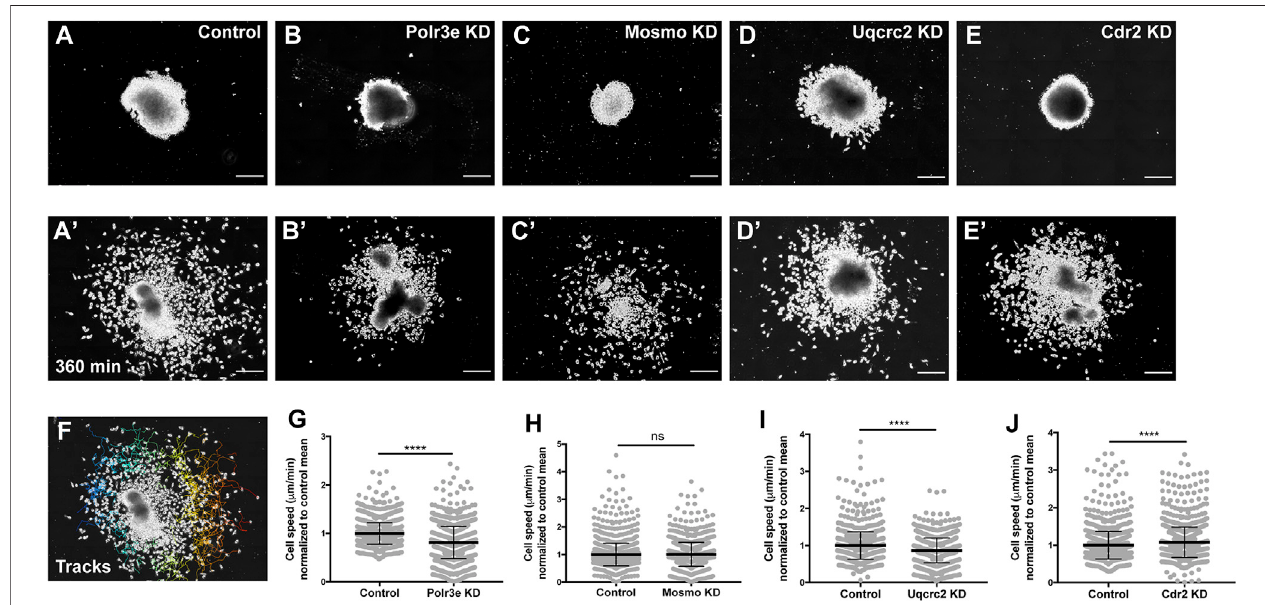
FIGURE 4 | Manipulation of Polr3e, Uqcrc2, and Cdr2 impacts NCC migration speeds in vitro . Dissected NCC explants from control, Polr3e KD, Mosmo KD, Uqcrc2KD,orCdr2KDembryoswereplatedon fi bronectin-coatedcoverslips,allowedtoadhereandbeginmigration,andimagedfor6 husing20xphasemicroscopy. (A – E) Representative images of explants at initial timepoint (0 min). (A 9 – E 9 ) Representative images of explants after 6 h migration (360 min). (F) Representative tracks generatedbyFiJiTrackmateplug-inoverlaidonpanelA ’ . (G – J) MeantrackspeedsofPolr3eKD,MosmoKD,Uqcrc2KD,andCdr2KDexplantscomparedtotheir controls.PartialdepletionofPolr3eandUqcrc2signi fi cantlyreducedmeanNCCspeed,whiledepletionofCdr2increasedmeanNCCspeed.PartialdepletionofMosmo had noeffecton mean NCC speed. (Explantsquanti fi ed: 6-7explantsfrom control and KDembryos wereplated for each experiment. Three separateexperiments were performed for each depletion.) **** p < 0.0001, *** p < 0.001, ** p < 0.01, * p < 0.05, n.s., not signi fi cant. Scalebar = 200 μ